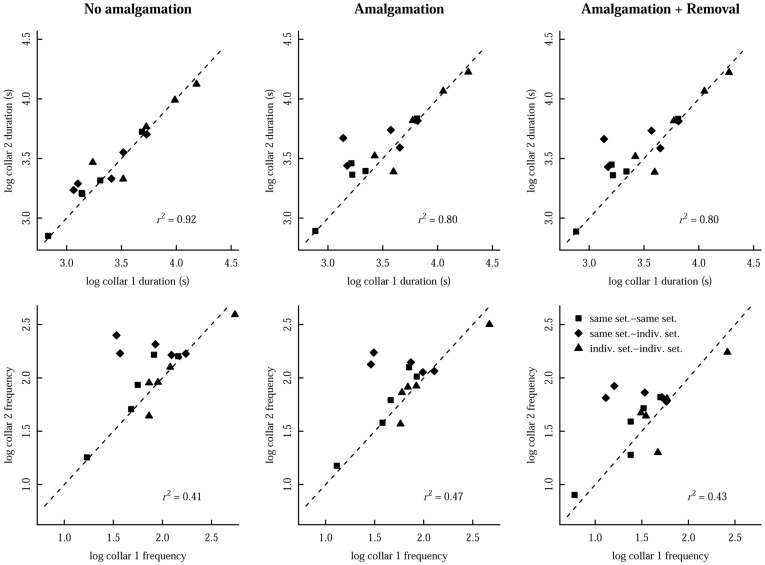
Correlations between contacts recorded by interacting pairs of badger proximity collars.Values are given for a) the duration and b) the frequency (number) of contacts for the 3 possible collar pairings based on their UHF settings (indiv. set.-indiv. set. (▴), indiv. set.-same set. (♦), same set.-same set. (▪)) and for the three data manipulation treatments to reflect the ‘real-life’ contacts (no amalgamation of broken contacts, amalgamation, amalgamation and removal of remaining 1 second contacts). The dashed line is the line of equivalence (y  =  x), along which all points would lie if collar 1 recorded exactly the same data as collar 2.